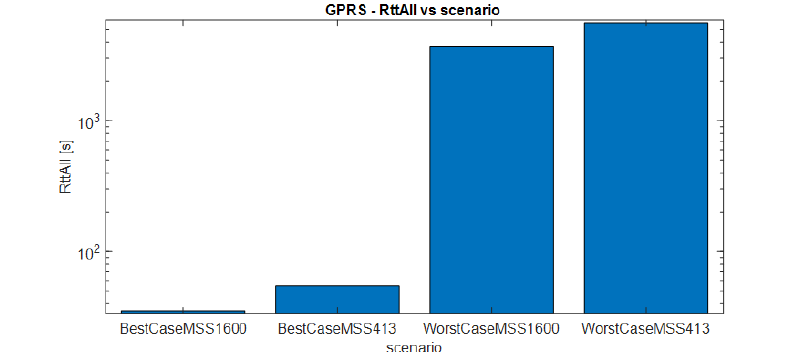
Figure 8. Round-Trip Time to communicate with All nodes (RTTAll) sensitivity with respect to the Maximum Segment Size for Scenario